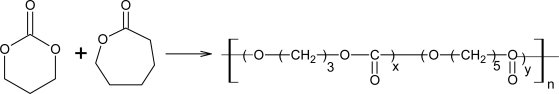
Synthesis of statistical poly(trimethylene carbonate-co-caprolactone).